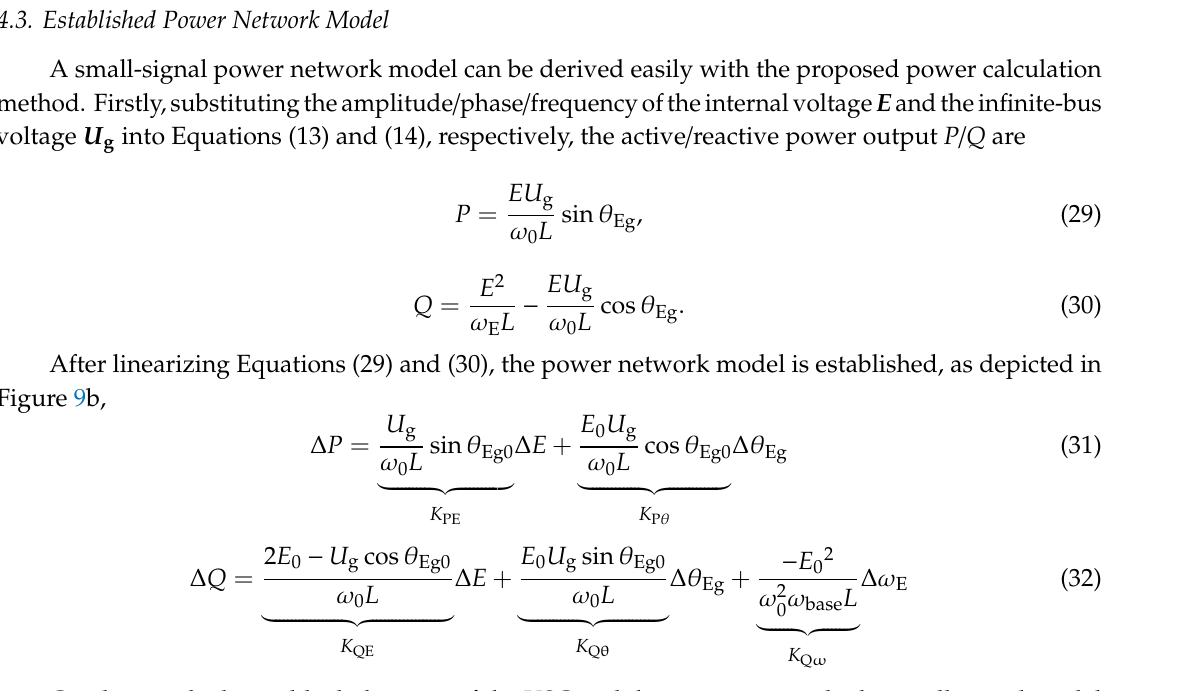
Figure 9. Established system model based on the motion equation concept. ( a ) VSC model. ( b ) Power network